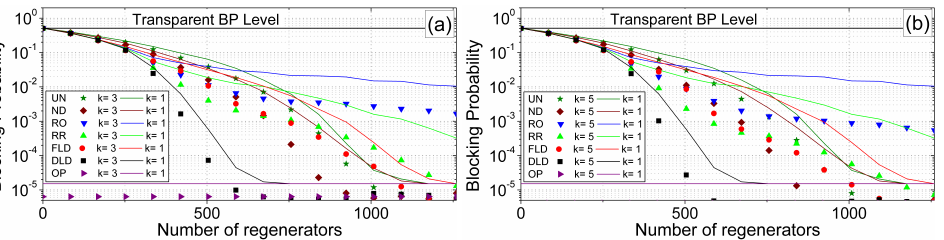
Figure 9. Blocking probability as a function of the total number of regenerators in EuroNet topology using k-shortest path routing algorithm for: ( a ) k = 3; ( b ) k = 5, each compared against the k = 1 case.